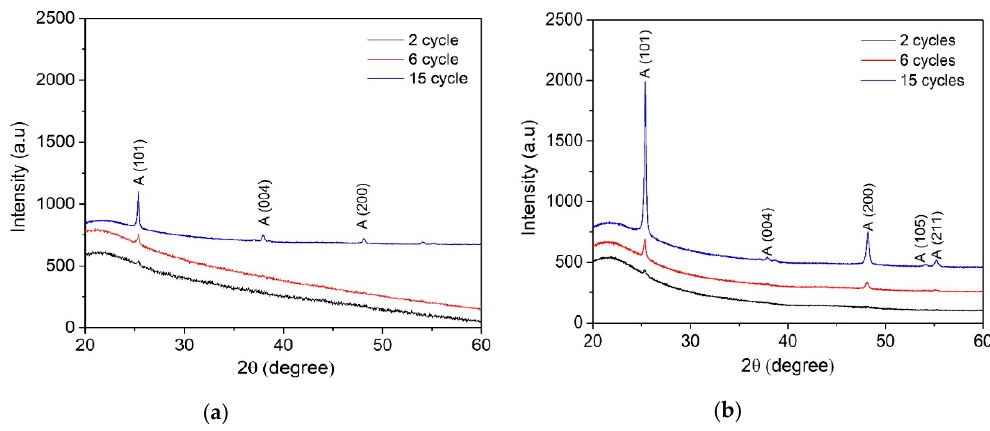
Figure 3. XRD patterns of TiO 2 films deposited from ( a ) 0.1 M solution with 2, 6, and 15 spray cycles and ( b ) 0.2 M solution with 2, 6, and 15 spray cycles.